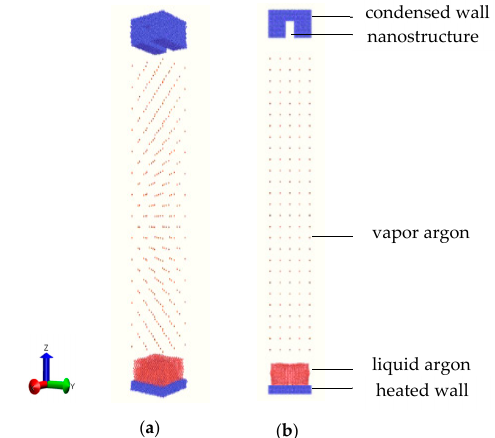
Figure 1. Schematic diagram of the ( a ) perspective and ( b ) orthographic views of the simulation domain. For the copper walls at the two ends of the system, the outermost two layers were defined as the fixed wall, to prevent the atoms flying away and plate deformation, and the remaining layers were treated as a thermostat with a heating temperature of 130 K and a cooling temperature of 85 K using the Nosé − Hoover thermostat [32,33]. For the liquid argon atoms, the film thickness was 3.6 nm with the number of 4739 atoms. For the dispersed vapor argons, they filled between the liquid film and the upper wall, with the number of 338 atoms. When the liquid layer was heated by the heat source, evaporation was triggered, and new vapor argons moved to the middle region to mix with the original ones. Finally, when the vapor argons arrived at the cold wall, condensation occurred. Here, the nanostructure grooves for vapor condensation had three different widths in the x-direction at 1.8, 2.4, and 3.2 nm, and for every width, three different heights of 0.8, 1.8, and 2.8 nm in the z-direction were